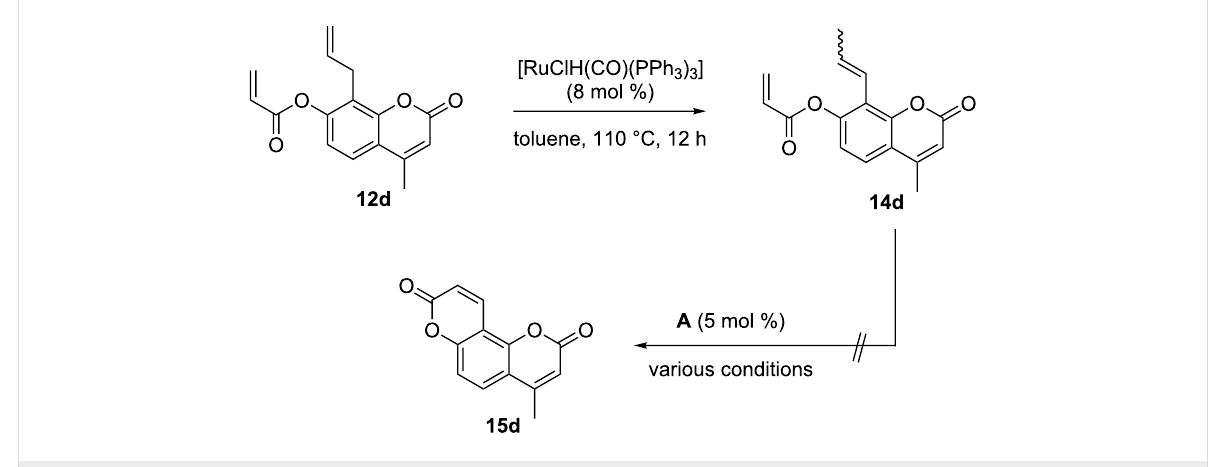
Scheme 2: Attempted synthesis of pyran-2-one-annellated coumarin 15d via